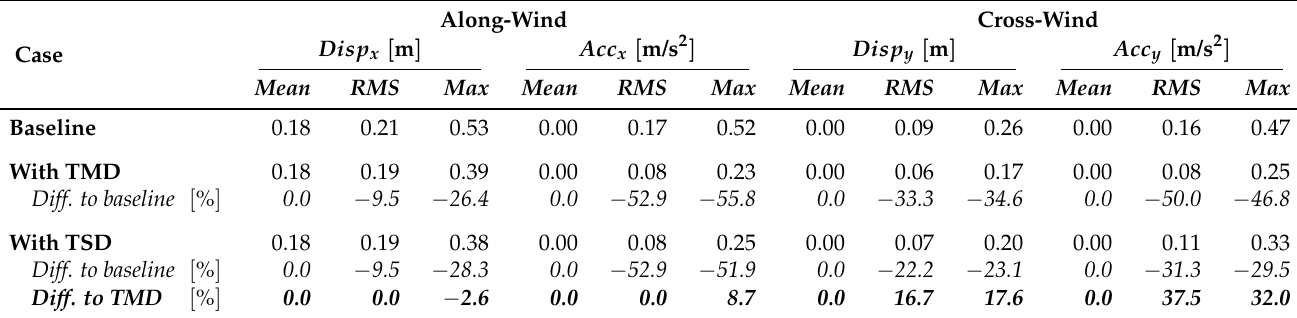
Table 3. Statistics of the kinematics of the top point under turbulent wind loading.